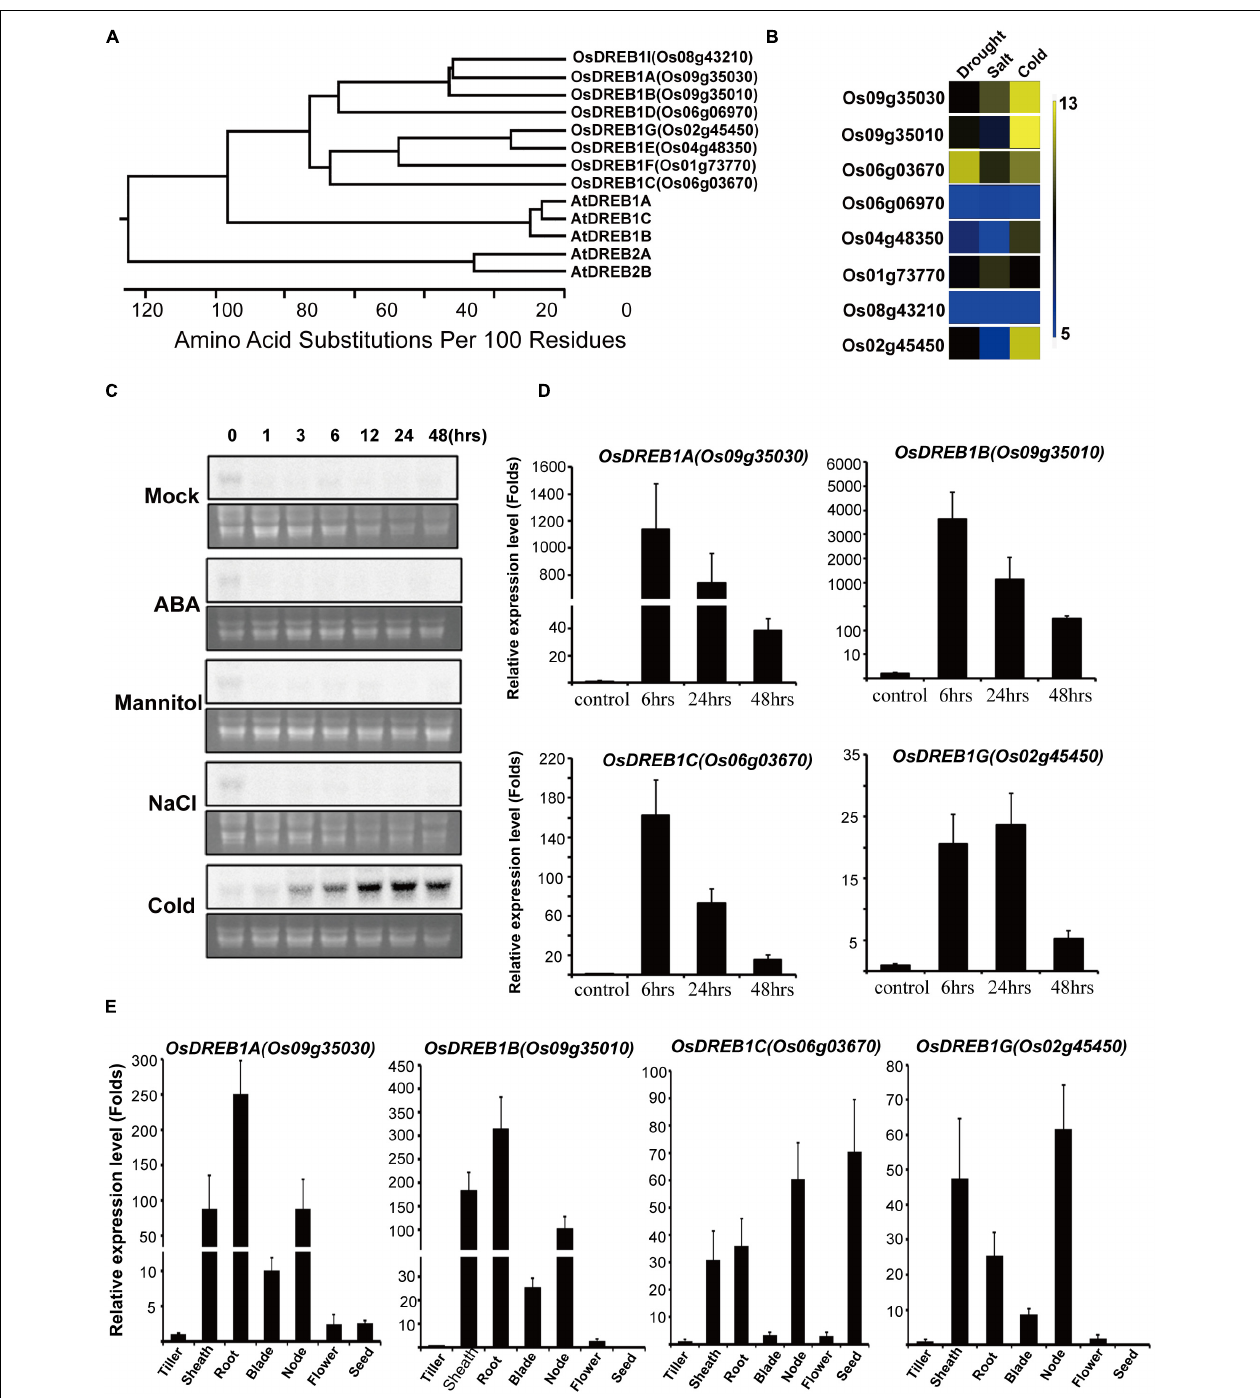
FIGURE 1 | OsDREB1G is specifically expressed in response to cold treatment. (A) Phylogenetic analysis of OsDREB1s . The phylogenetic tree was constructed based on the deduced amino acid sequence of OsDREB1 and other AP2 domain protein sequences using the DNASTAR program (DNASTAR, Inc., Madison, WI, United States). (B) Gene expression analysis of several OsDREB1s under different abiotic stress treatments using genevestigator microarray database (GSE6901). (C) OsDREB1 is specifically upregulated in response to cold stress treatment. Total RNA was isolated from 2-week-old rice plants treated with ABA (100 µ M), mannitol (150 mM), NaCl (150 mM), or cold (4 ◦ C). A gel pre-stained with ethidium bromide (lower panels) was used to confirm equal loading in all wells. (D) Gene expression analysis of OsDREB1s in several time intervals under cold treatment. RNA was isolated from 2-week-old plants grown in 1/2MS media. (E) Gene expression analysis of OsDREB1Gs in different tissues. RNA was isolated from the tissues of 1 or 2-month-old plants. Error bars indicate standard errors. The experiments were performed with at least three biological repetitions.